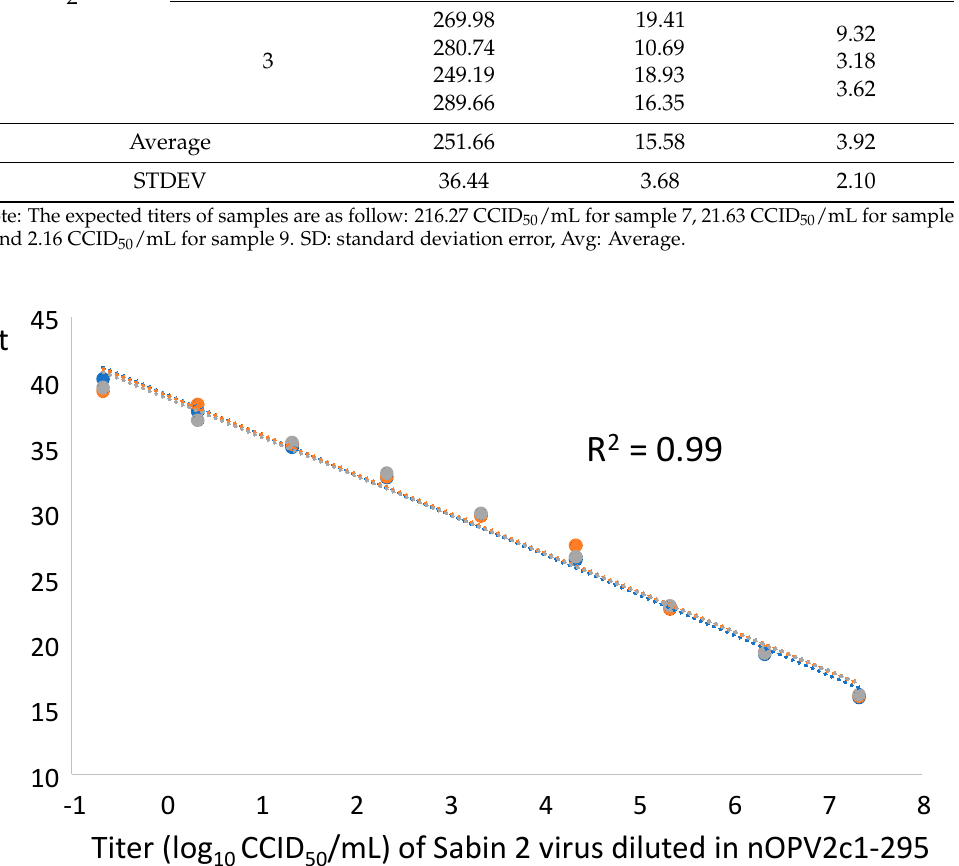
Figure 4. The three repeats of qosRT-PCR analysis (each repeat is presented in one line) of Sabin 2 virus in presence of prevalent amounts of nOPV2: Sabin 2 virus (titer 8.34 log 10 CCID 50 /mL) was serially diluted in 10-fold steps in nOPV2c1-295 virus (titer of 8.07 log 10 CCID 50 /mL). All diluted samples were subjected to RNA extraction and then to the assay analysis. The R 2 is around 0.99 for each repeat of the analyzed samples. Table 3. Detection and quantification of Sabin 2 virus serially diluted in nOPV2c1-295.